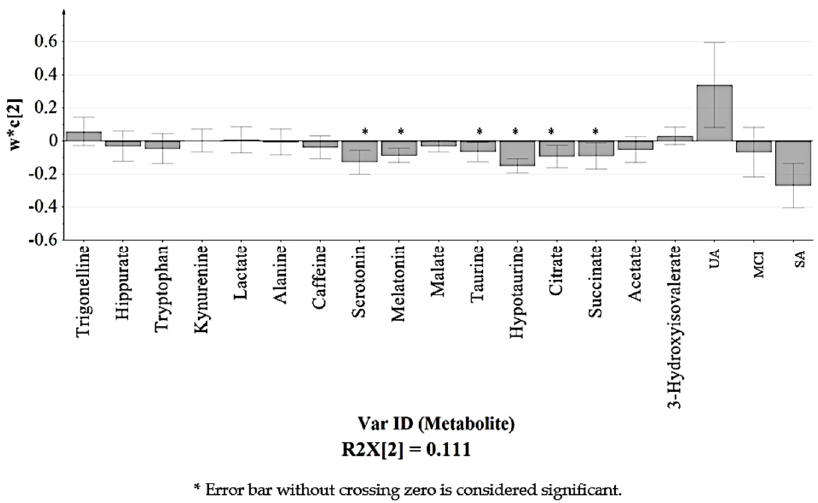
Figure 5. Loading column plot of PLS-DA model (Figure 4) observed by PC 2 (w*c(2)). Each column represents the putative identified urinary metabolite with standard errors displayed in error bar.